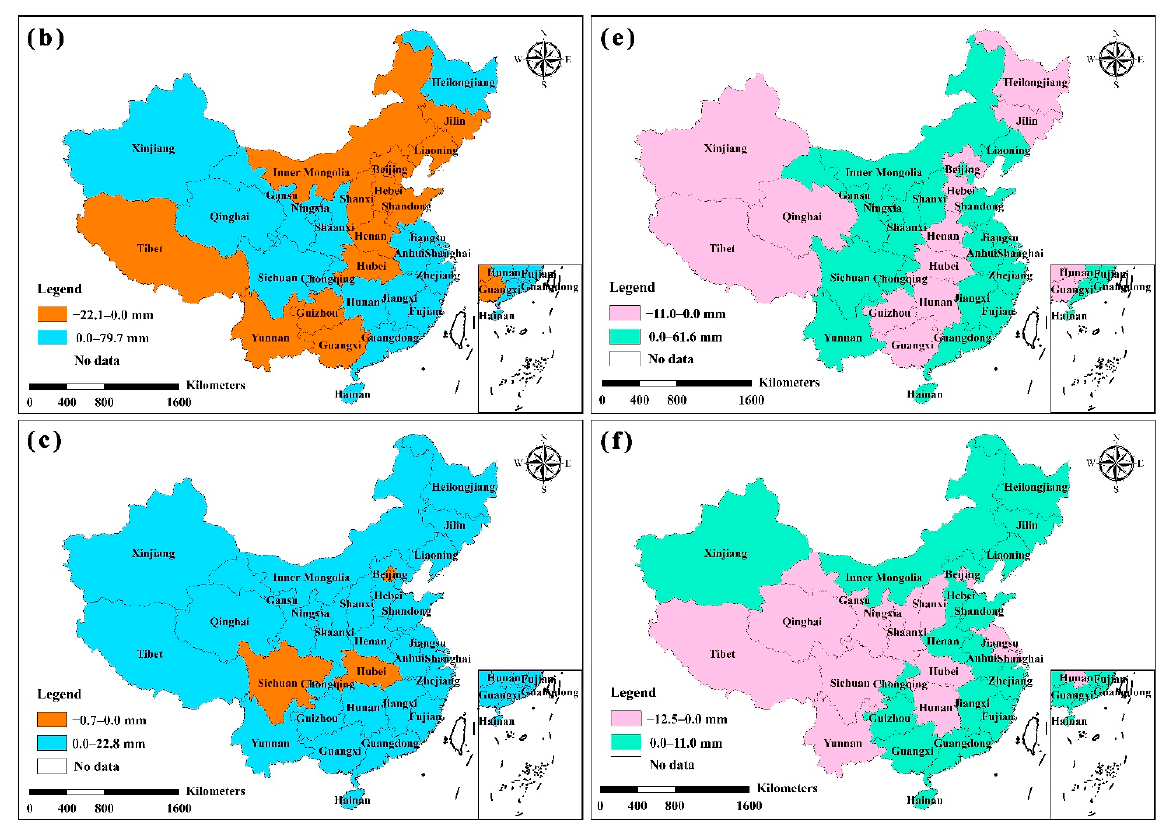
Figure 7. Precipitation changes prior to (1960–1969) and following (2010–2019) urbanization for ( a ) the whole year, ( b ) summer, and ( c ) winter. Changes to the rain island effect for ( d ) the whole year, ( e ) summer, and ( f ) winter following urbanization.